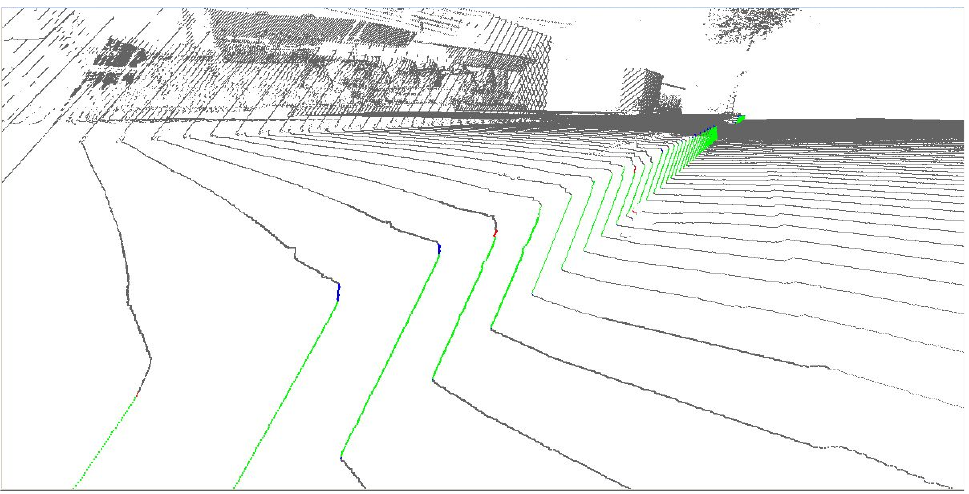
Figure 15: The comparison of extracted curb points. The correct point, the false positive point and the false negative point are colored in green, blue and red, respectively.